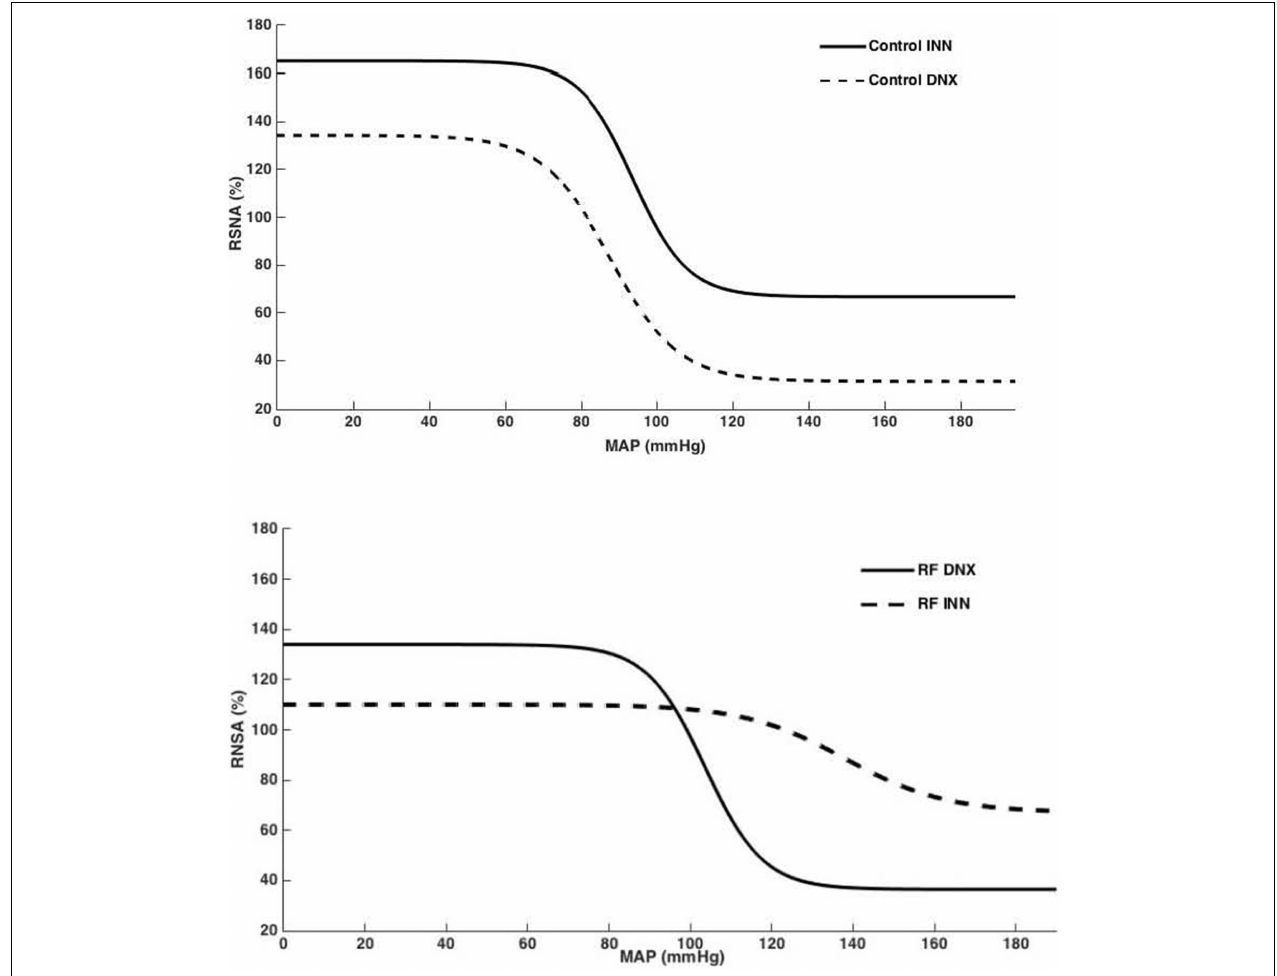
FIGURE 5 | Baroreflex curves for RSNA (%), generated from mean A1–A4 values for control innervated (control INN) and denervated (control DNX) and renal failure (RF) innervated (RF INN) and denervated (RF DNX)